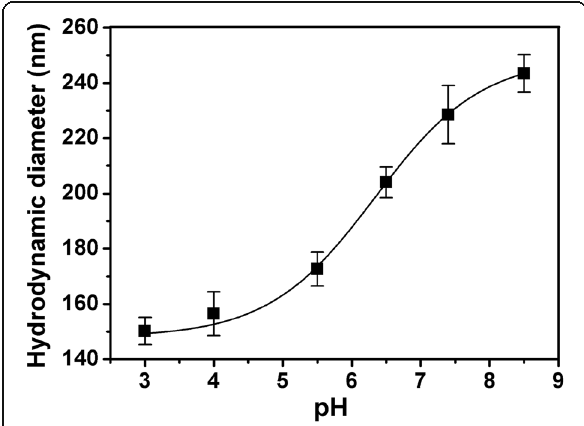
Fig. 3 Hydrodynamic diameter of PDA@PMAA-1 nanoparticles in phosphate buffer at various pH